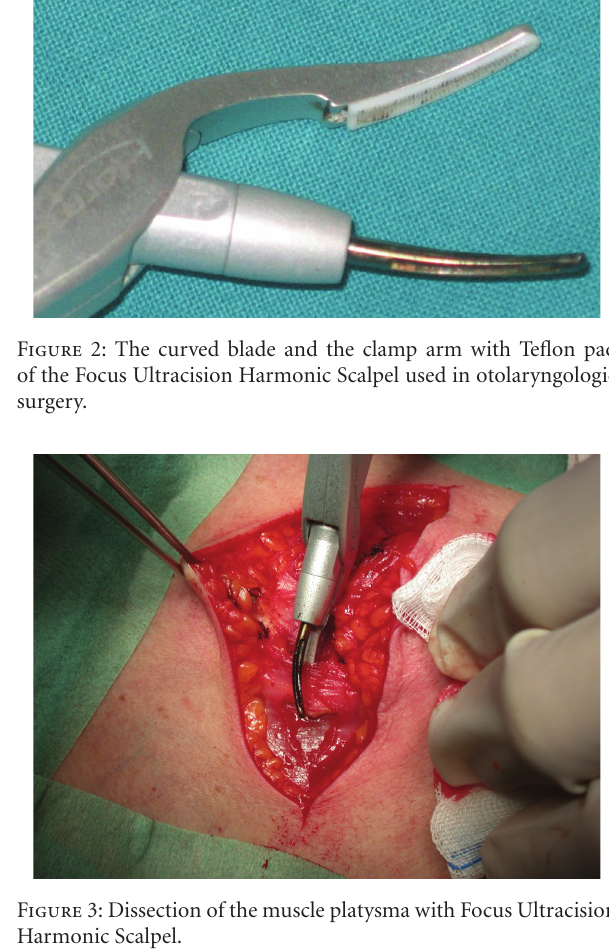
Figure 5: Postoperative thyroid specimen (multinodular